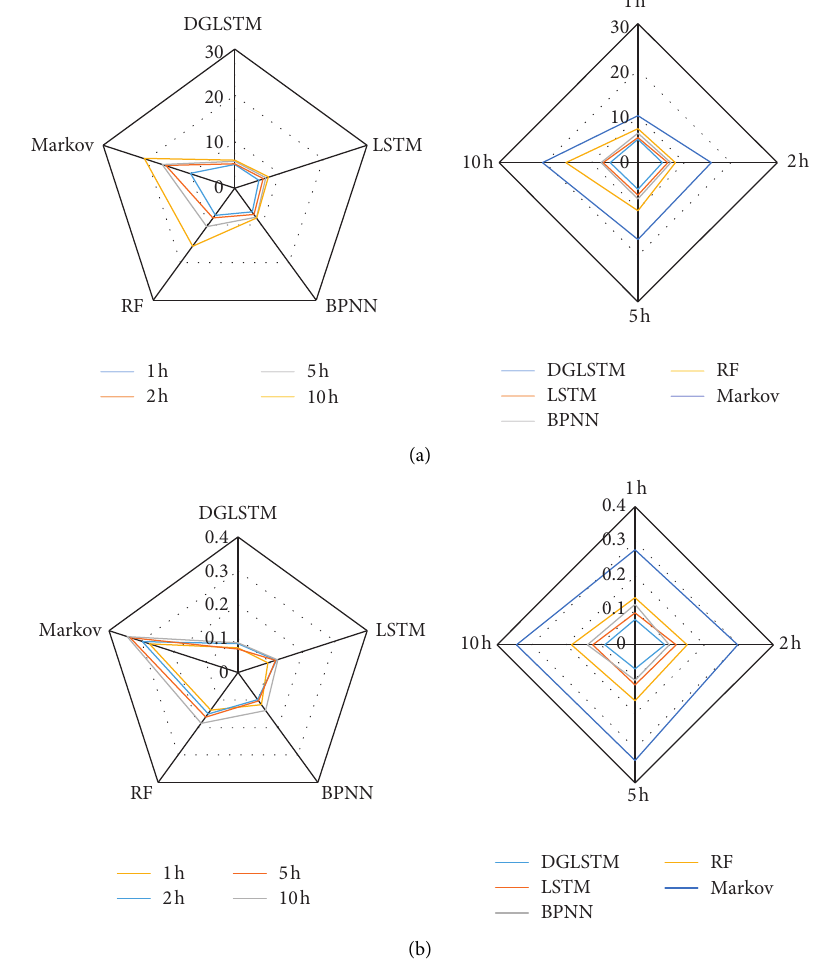
Figure 10: Comparison of experimental results of different methods. (a) MAE. (b)